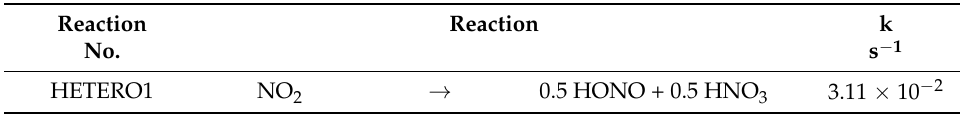
Table 2. NO 2 heterogeneous reaction on flow tube